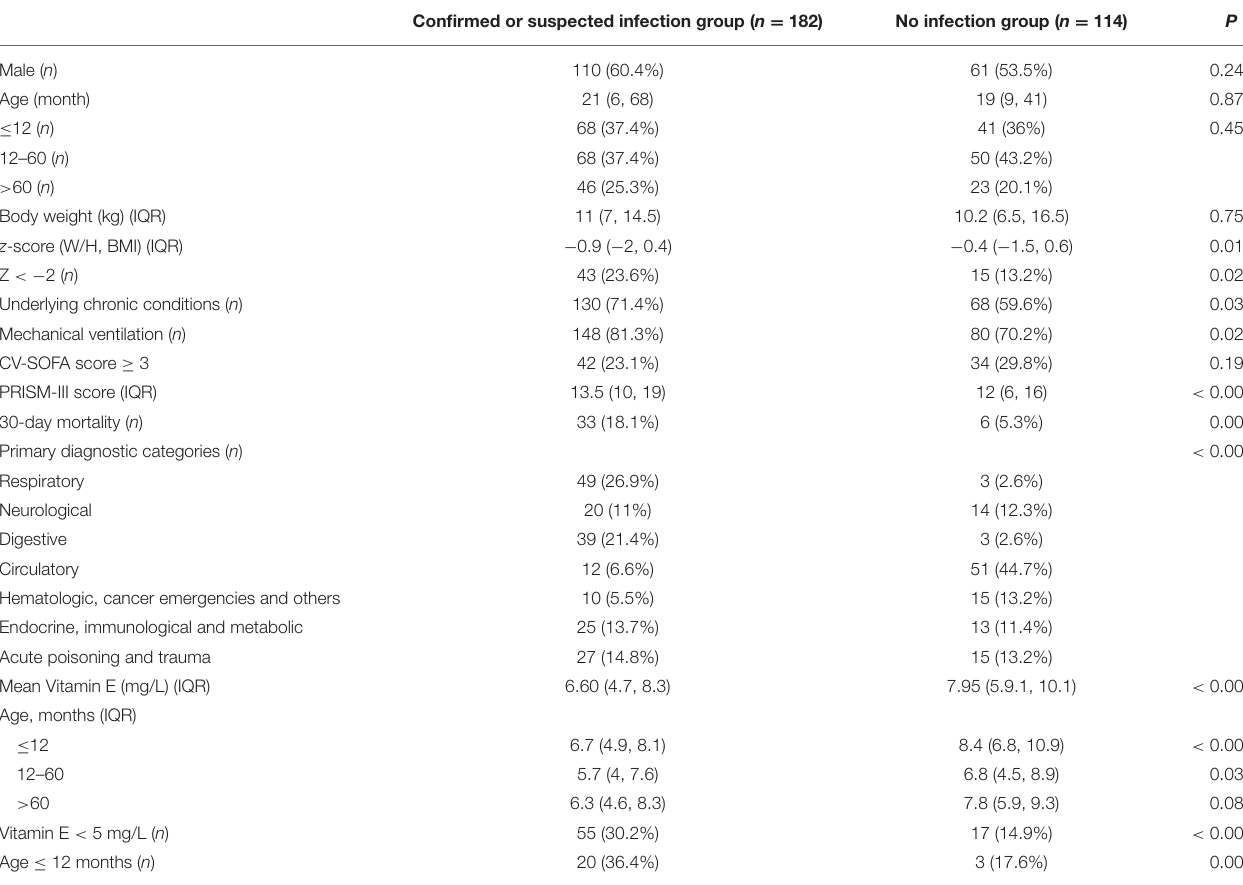
TABLE 1 | Characteristics of subjects on PICU